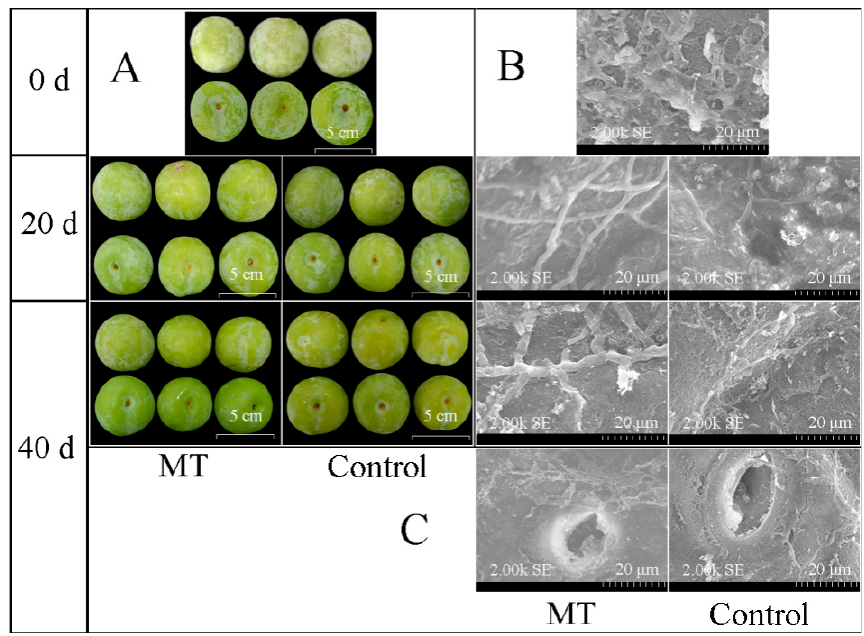
Figure 1. Melatonin treatment affects ‘Kongxin’ plum fruit appearance and peel microstructure during low-temperature storage. ( A ) fruit appearance at 0, 20 and 40 d; ( B ) peel microstructure at 0, 20, and 40 d; ( C ) fruit lenticels at 40 d.